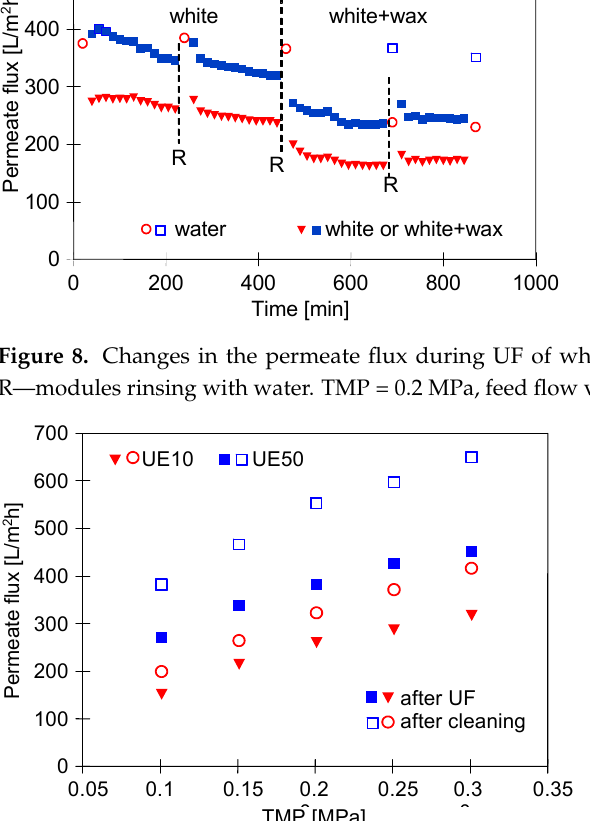
Figure 9. Impact of the TMP on the maximum permeate flux for the membranes after separation of the white+wax mixture (Figure 8) and after membranes cleaning with NaOH solution (0.5 g/L) for 2 h.